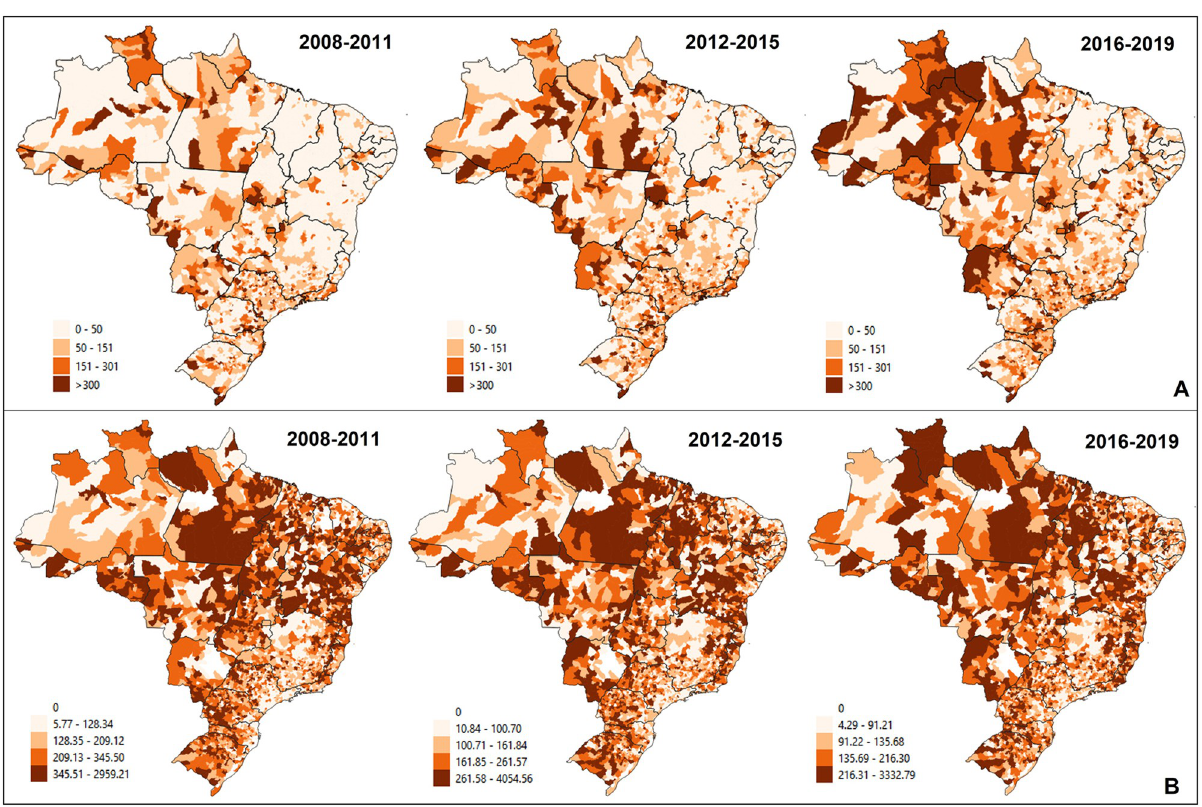
Fig 1. Smoothed PCSC rate in the first thousand days. Brazil, 2008–2019. (A) PCSC rate in women due to causes related to related to prenatal care and childbirth. (B) PCSC rate in children under two years of age.